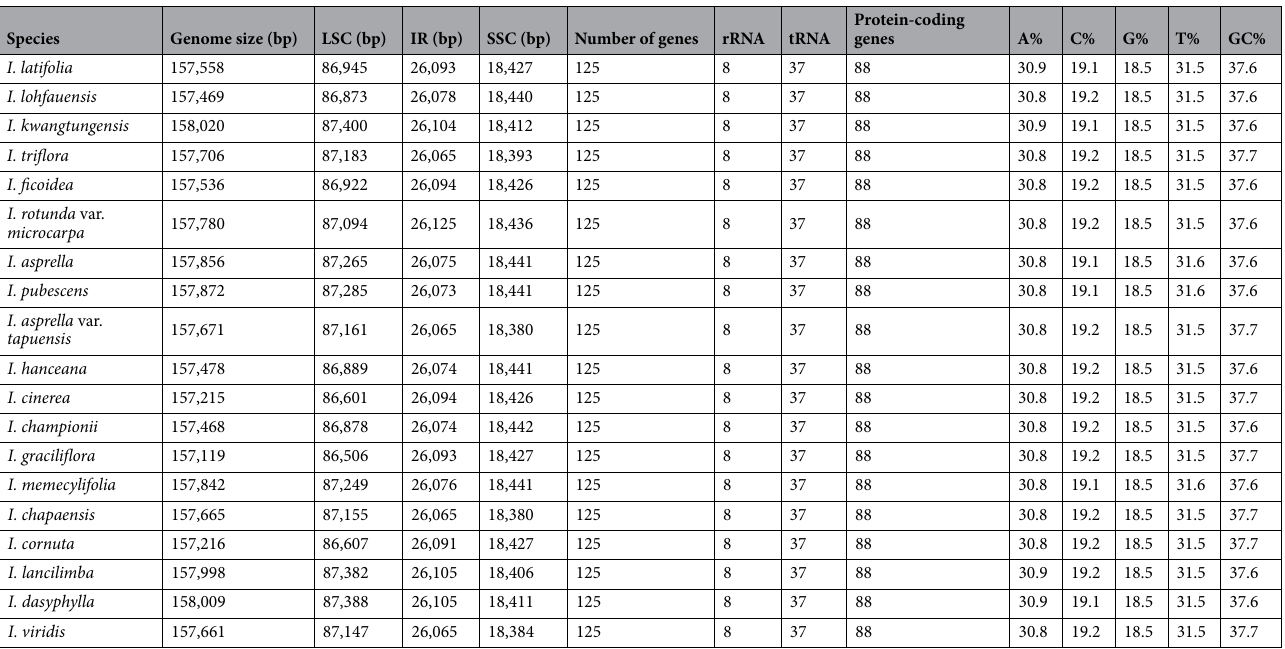
Table 1. Summary of the assembly data for Ilex chloroplast genomes.